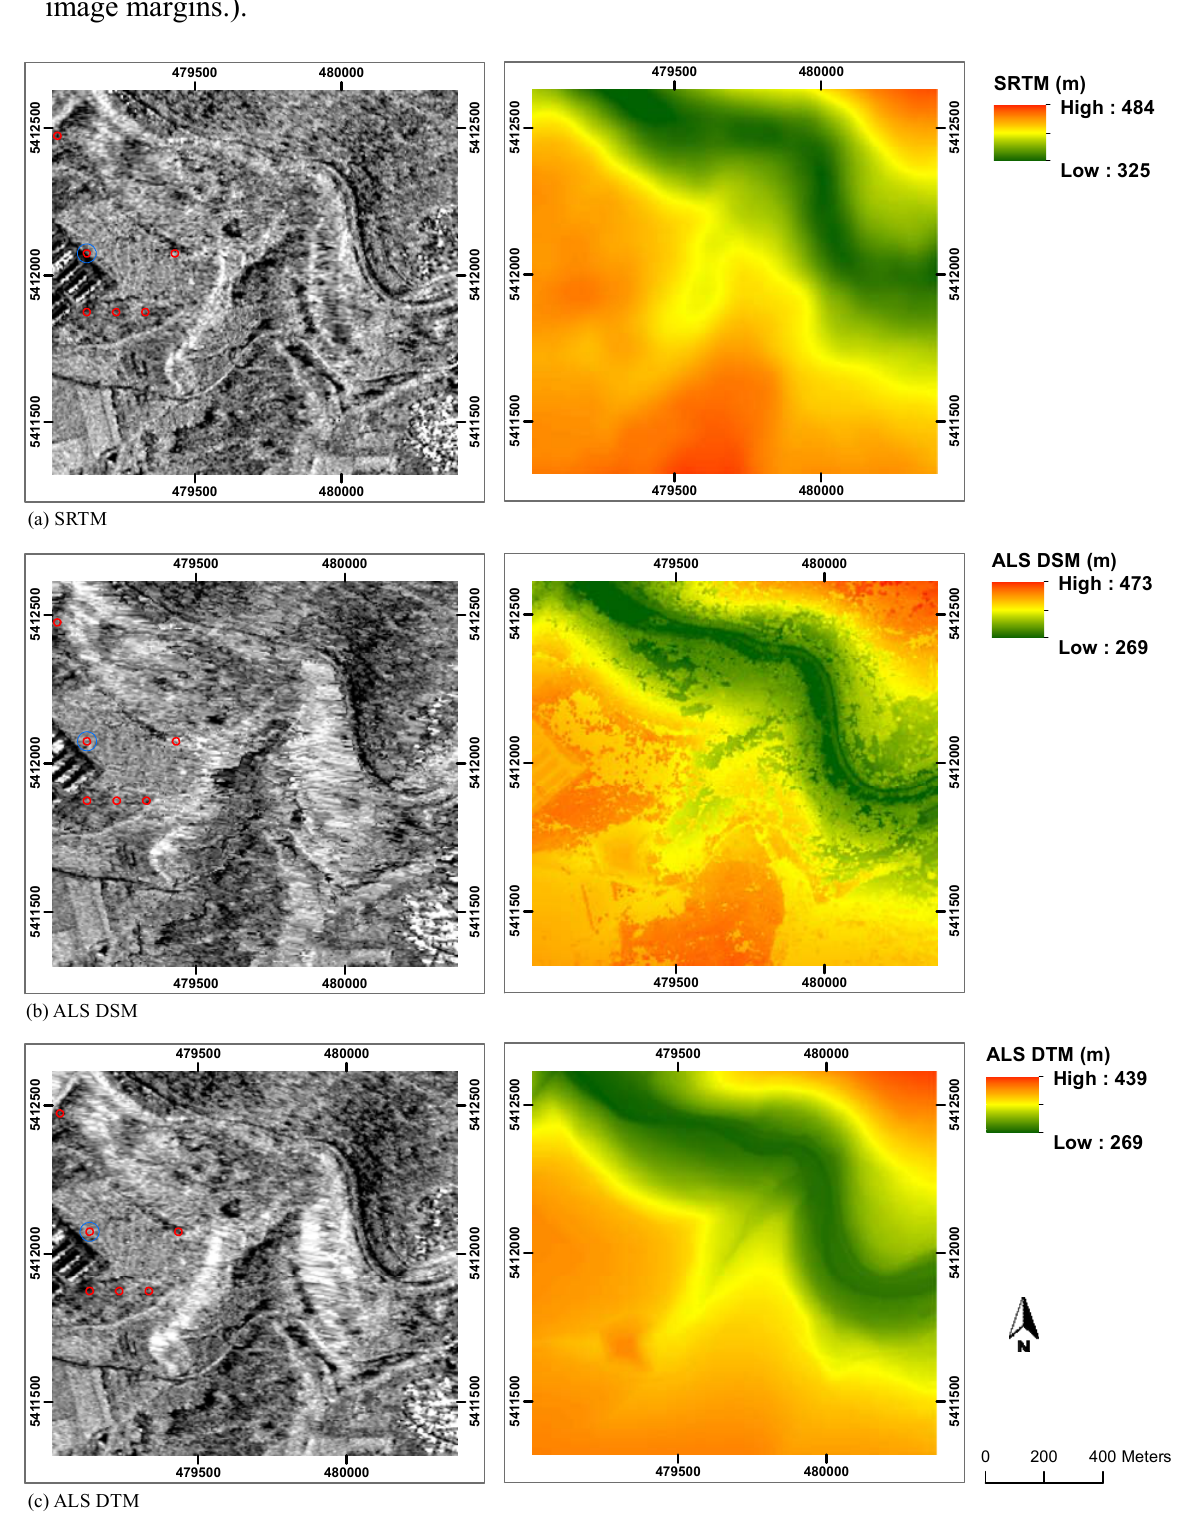
Figure 3. Example of orthorectified images of Pforzheim in leaf-off conditions ( left ) and DEMs used for the orthorectification ( right ). Inventory plots are shown as red circles. The big blue circle highlights a sample plot that was located in another land use class in the image orthorectified with the SRTM (UTM coordinates of zone 32N are displayed in the image